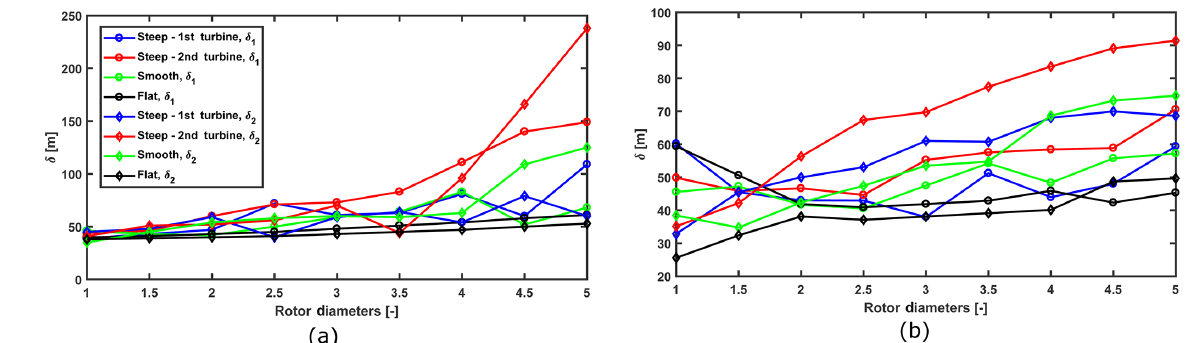
Figure 13. Right and left wake half-width for the (a) lateral and (b) vertical velocity deficit profiles.